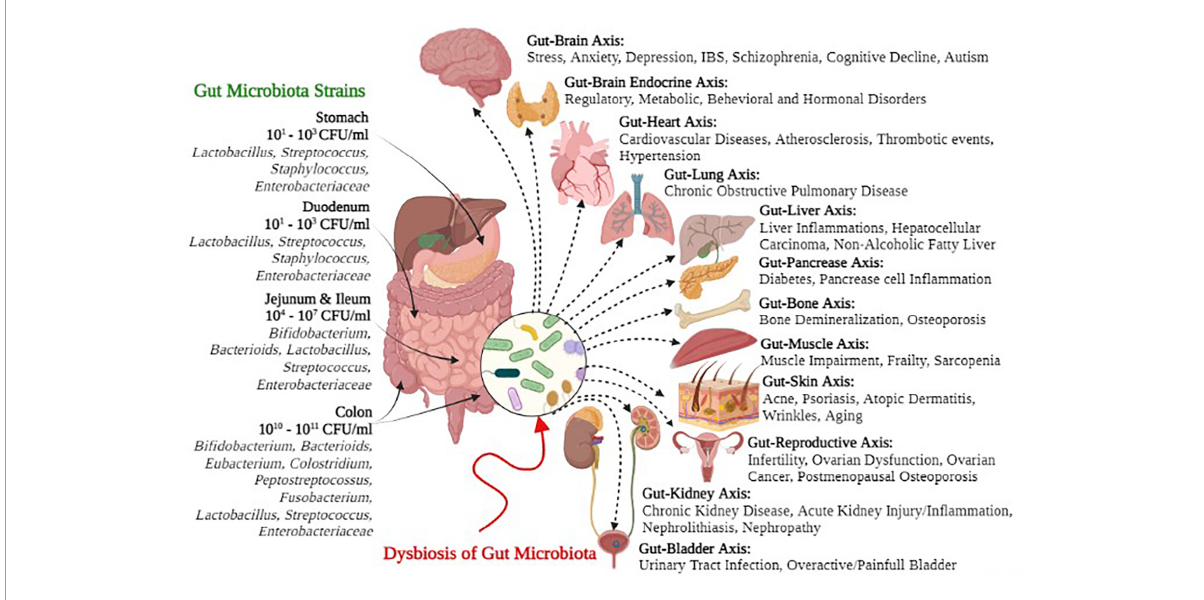
FIGURE1 Gut microbial strains and negative health outcomes of gut microbial